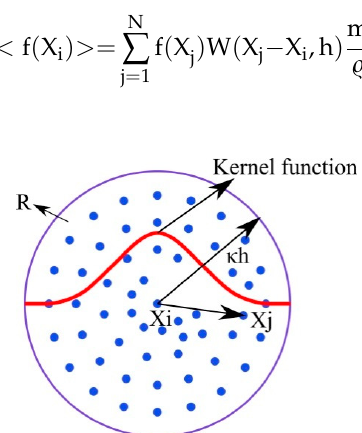
Figure 1. Support domain of kernel function centered at particle X i .